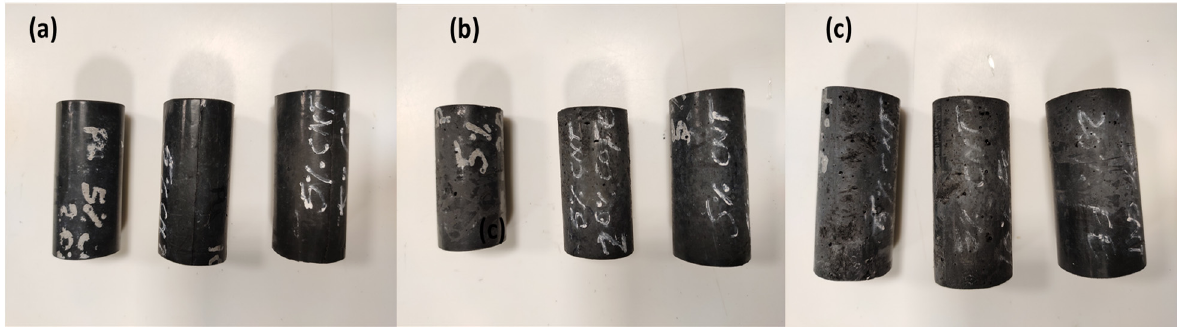
Figure 1. Functionalized samples ( a ) PU + 5%CNT + (5%, 10%, 20% Co), ( b ) PU + 5%CNT + (5%, 10%, 20% CoFe), ( c ) PU + 5%CNT + (5%, 10%, 20% Fe).